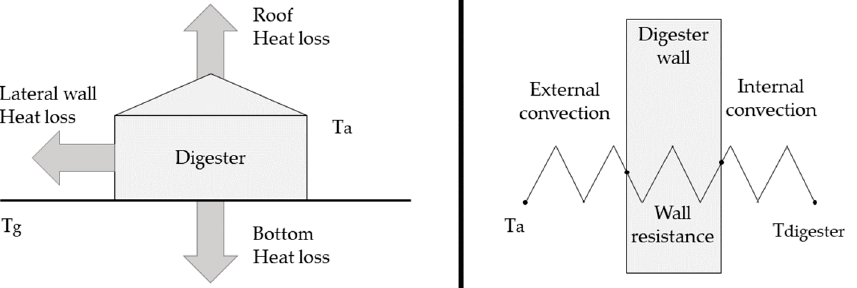
Figure 3. Heat loss from the digesters.